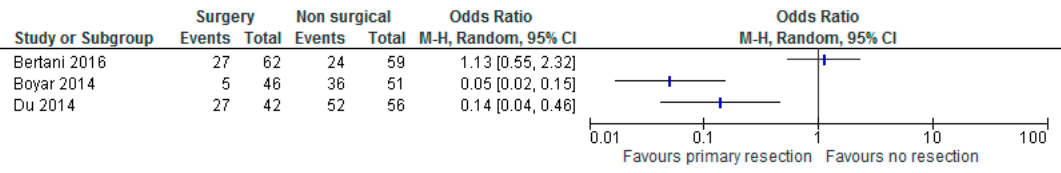
Figure 2. Forest plot for overall survival (OS) after resection of primary tumour versus no resection at all.